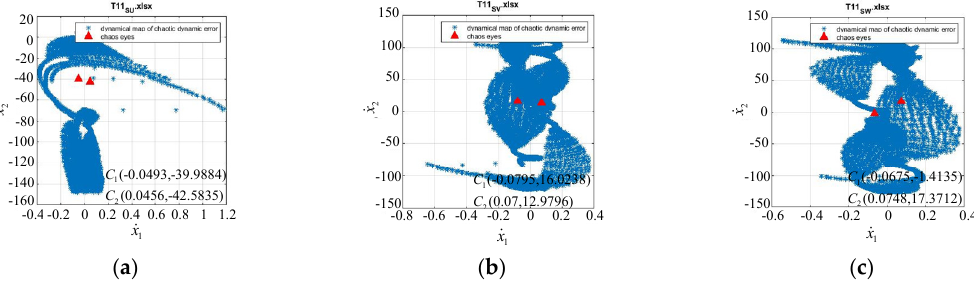
Figure 7. Chaotic scatter diagrams of each phase voltage of the inverter operating at 60 Hz and under conditions of a faulty S a 1+ : ( a ) Phase voltage v ao ; ( b ) phase voltage v bo ; ( c ) phase voltage v co .